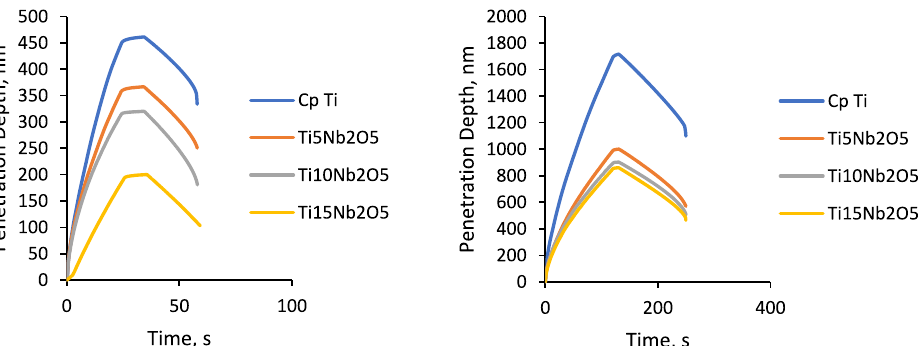
Fig. 4. (a) Penetration depth with time at 20mN (b) Penetration depth with time at 100mN.